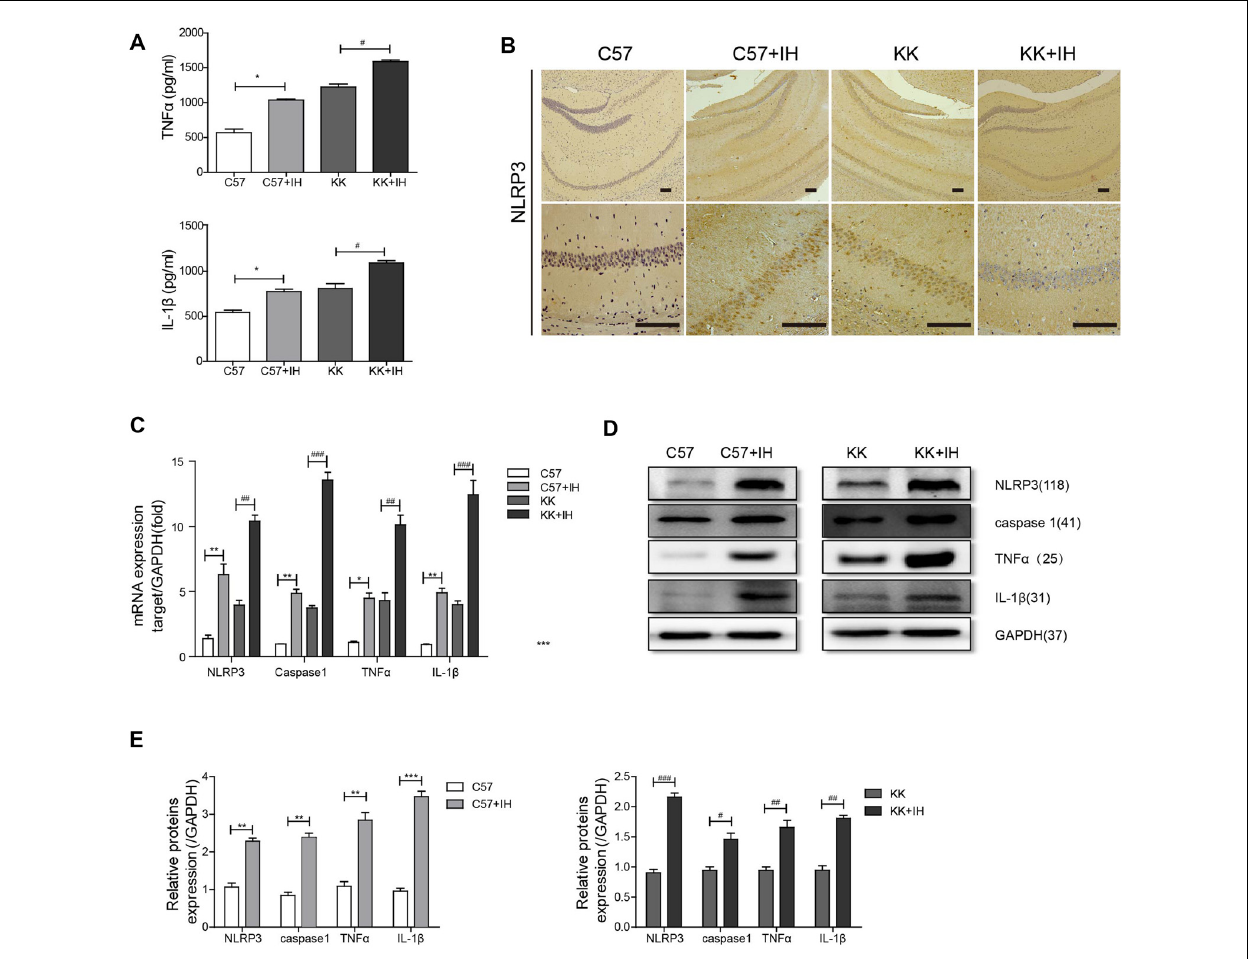
FIGURE 1 | The inflammatory response in the brain was increased in type 2 diabetes mellitus (T2DM) mice exposed to intermittent hypoxia (IH). (A) Tumor necrosis factor- α (TNF- α ) and interleukin-1 β (IL-1 β ) in mouse serum were measured by enzyme-linked immunosorbent assay (ELISA). (B) NLRP3 expression was determined by immunohistochemistry (IHC). Scale bars in the right lower corner represent 20 mm. (C) NLRP3, caspase 1, TNF- α and IL-1 β levels were determined by Real-time quantitative polymerase chain reaction (qRT-PCR). (D,E) NLRP3, caspase 1, TNF- α and IL-1 β levels were determined by western blot. The data are presented as